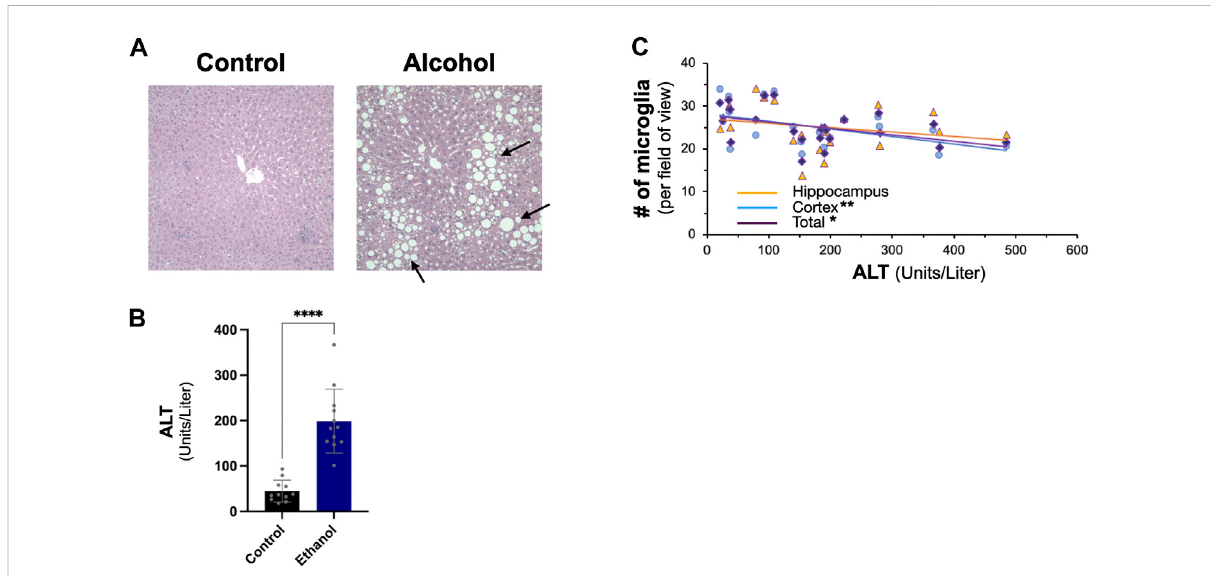
Effect of intragastric alcohol feeding on liver injury and its relationship with microglial number in the brain. (A) Hematoxylin and eosin (H&E) histologyofmiceliverfollowing4 weeksofintragastricalcoholfeeding(×200magni fi cation).Thearrowspointtolipiddropletsintheliverassociated with steatosis. Representative samples of intragastric alcohol fed and control mice are shown. (B) ALT levels in serum following 4 weeks of intragastric alcohol feeding to mice. n = 6 – 7 mice. Results are mean ± SD. (C) Scatter plot showing the relationship between liver injury (ALT levels) and microglial number in the brain. **** p < 0.0001, ** p < 0.01, or * p < 0.05 vs.